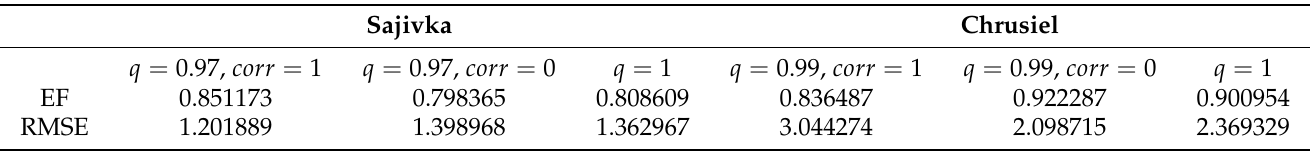
Table 6. Statistical model indicators RMSE and EF, evaluated for the comparison of the fractional- order and RothC models in the Sajivka and Chrusciel